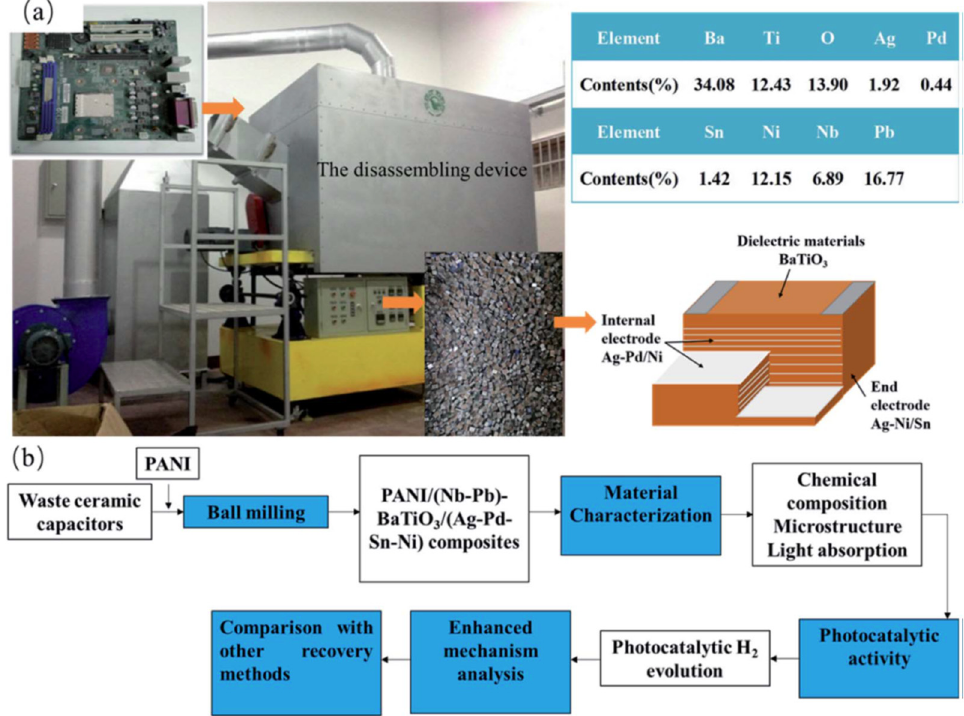
Figure 16. ( a ) The waste multilayer ceramic capacitors (including dielectric material BaTiO 3 , internal electrode Ag-Pd/Ni, and end electrode Ag-Ni/Sn), disassembling from the circuit board and corre- sponding content elements and ( b ) the processing diagram for production of Nb-Pb-co-doped and Ag-Pd-Sn-Ni loaded BaTiO 3 photocatalyst with PANI [173].